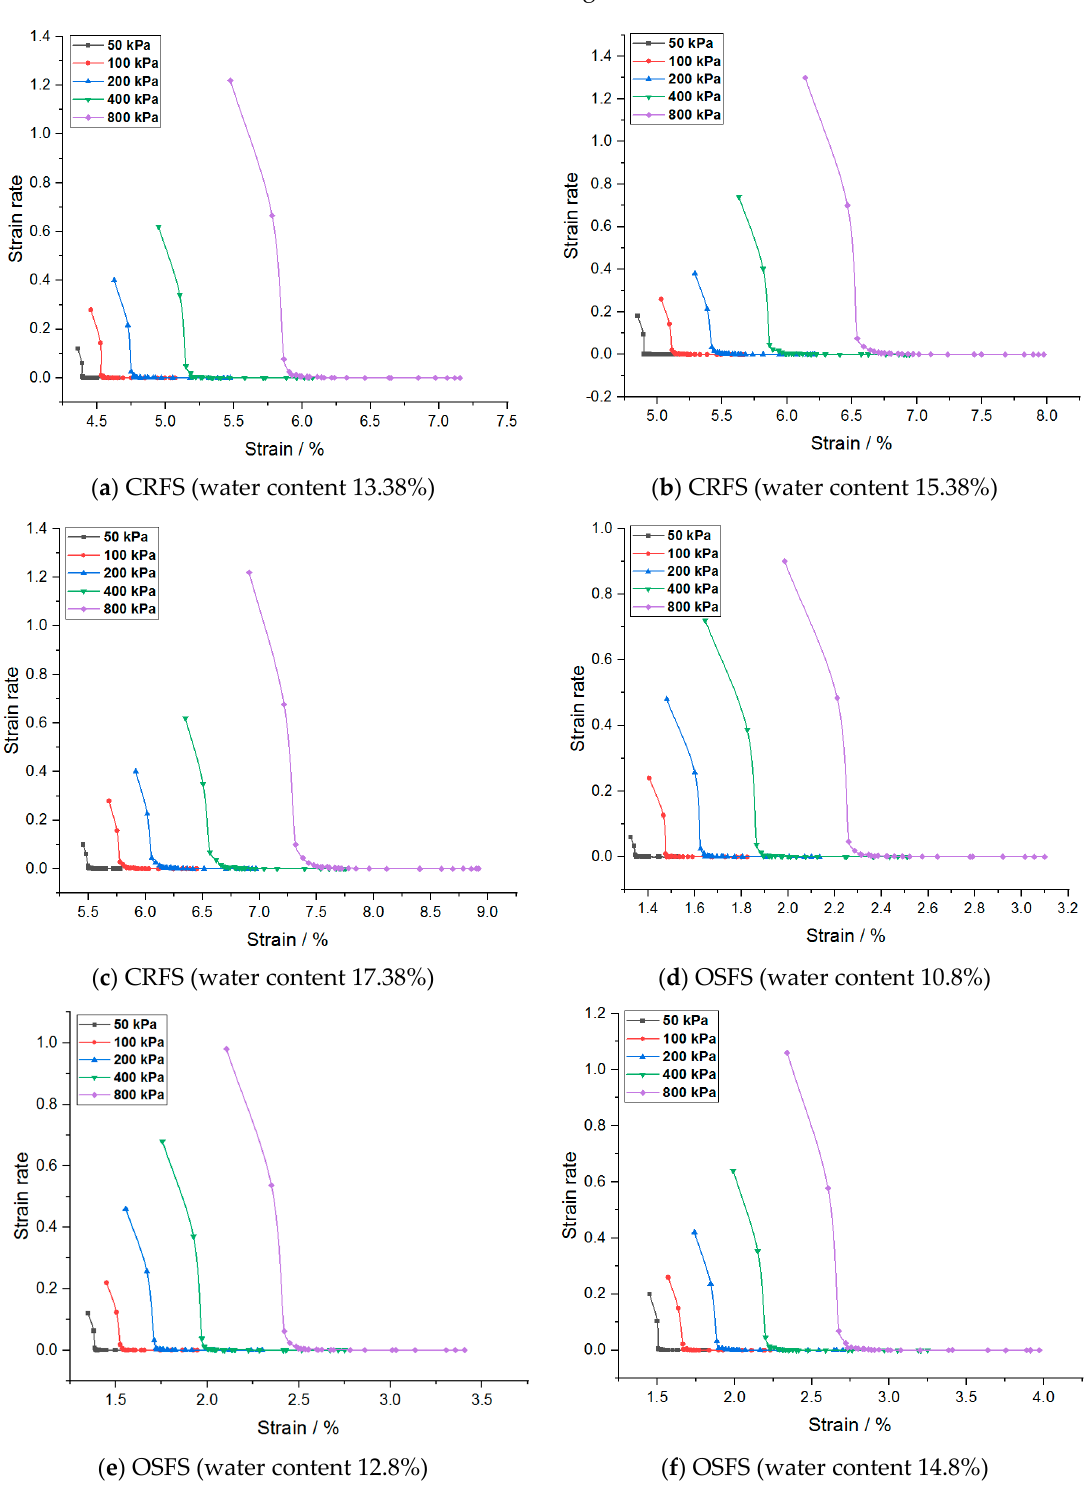
Figure 7. Strain rate–strain curves of modified soil with different water contents.